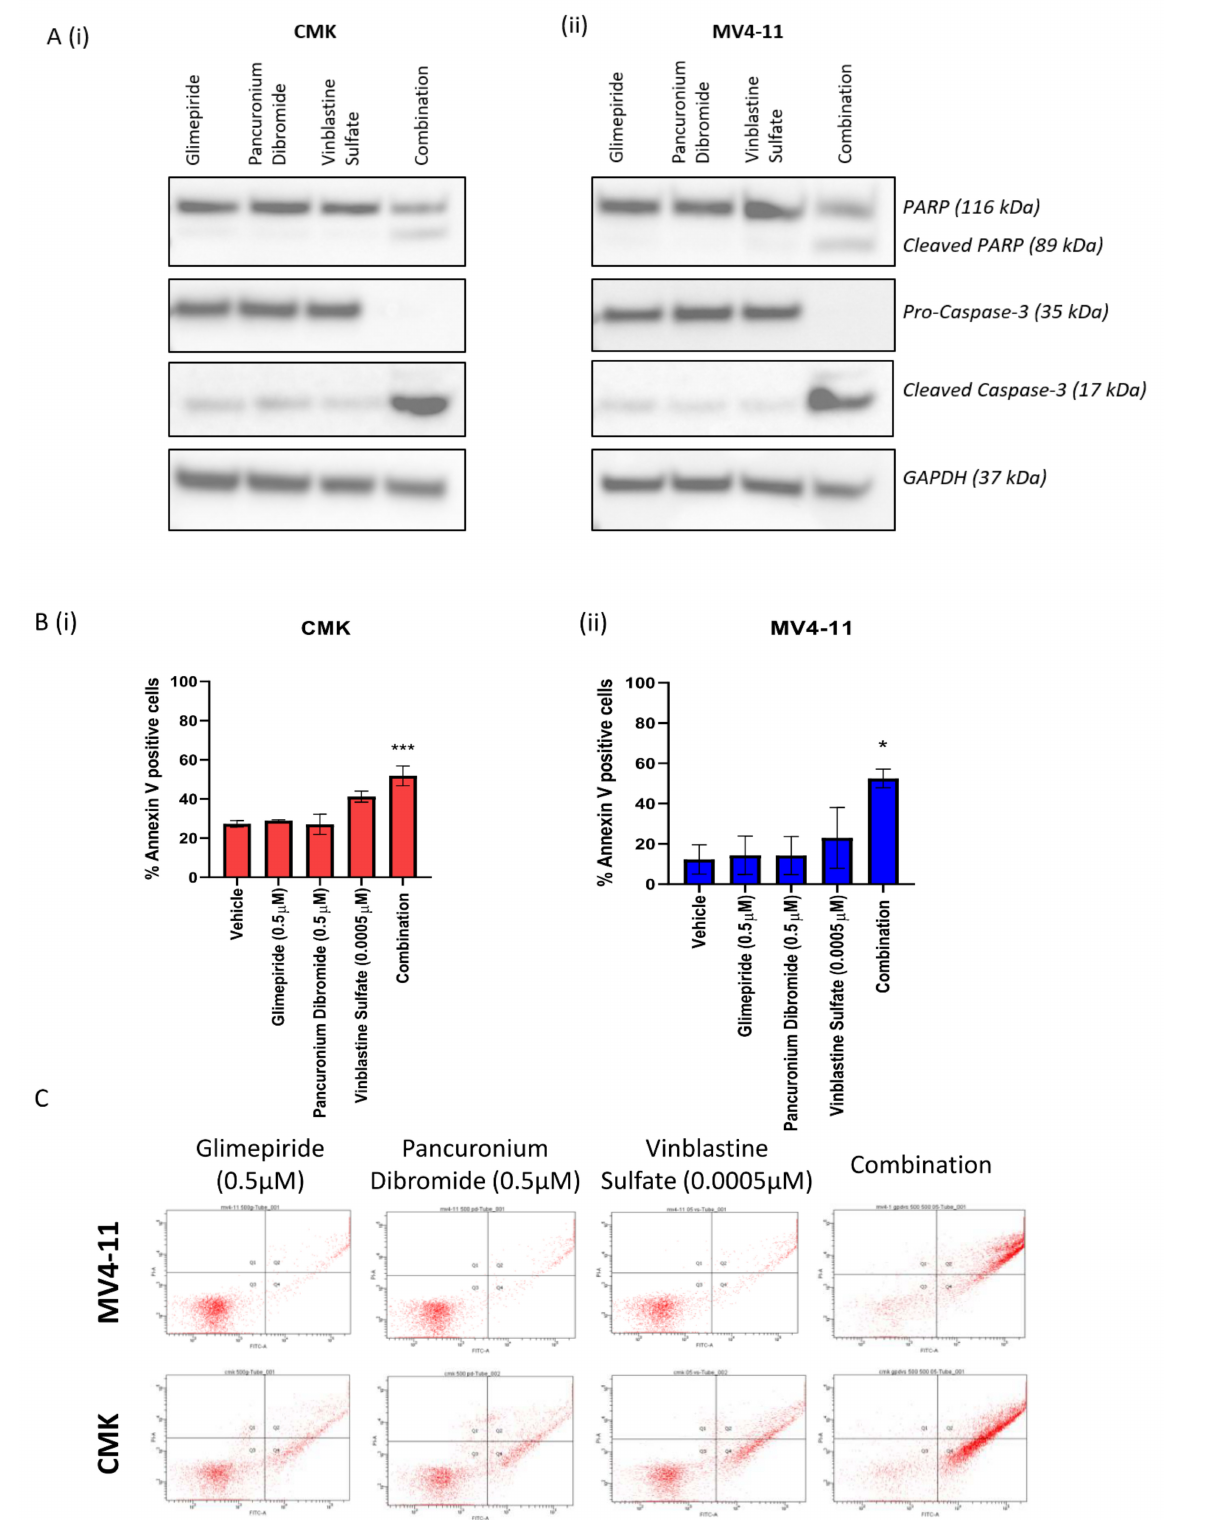
Figure 5. The triple combination of glimepiride, pancuronium dibromide and vinblastine sulfate induces cell death in paediatric AML cell lines. ( A ) Western blot analysis of PARP, procaspase-3, and cleaved caspase-3 in the ( i ) CMK and (ii ) MV4- 11 cell lines following 72 h treatment with glimepiride (0.5 µ M), pancuronium dibromide (0.5 µ M) and vinblastine sulfate (0.0005 µ M) as single agents and as a combination. GAPDH was used as a loading control. Results shown are